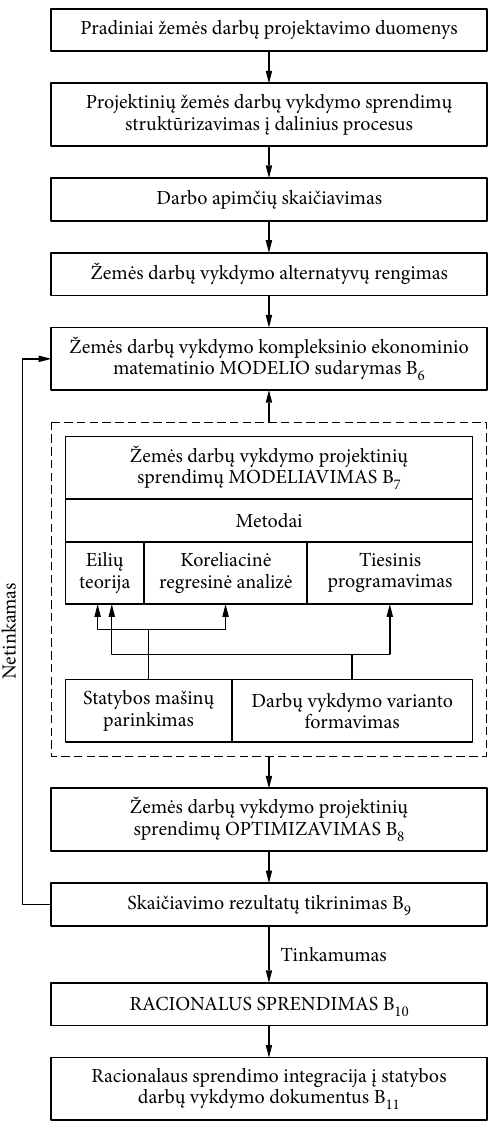
Fig. 4. The block scheme for the optimization of designed decisions on earthwork